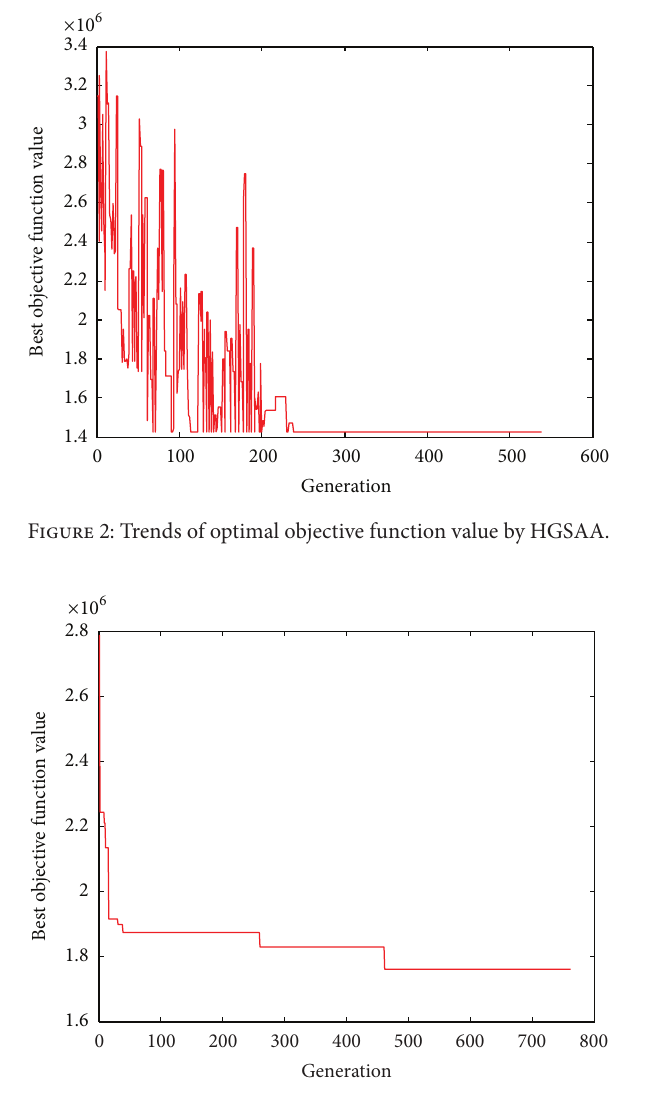
Figure 3: Trends of optimal objective function value by GA.